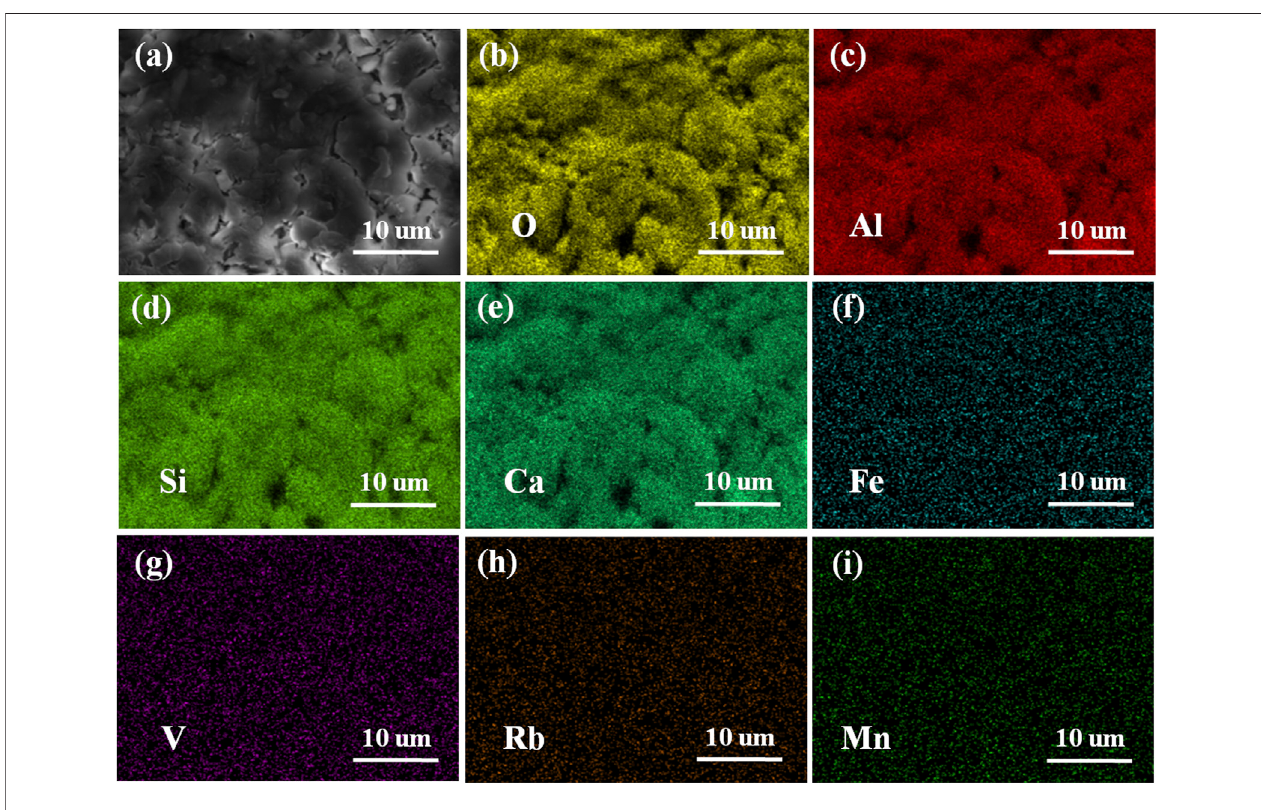
FIGURE 4 | EDS elemental maps of KCC-0.